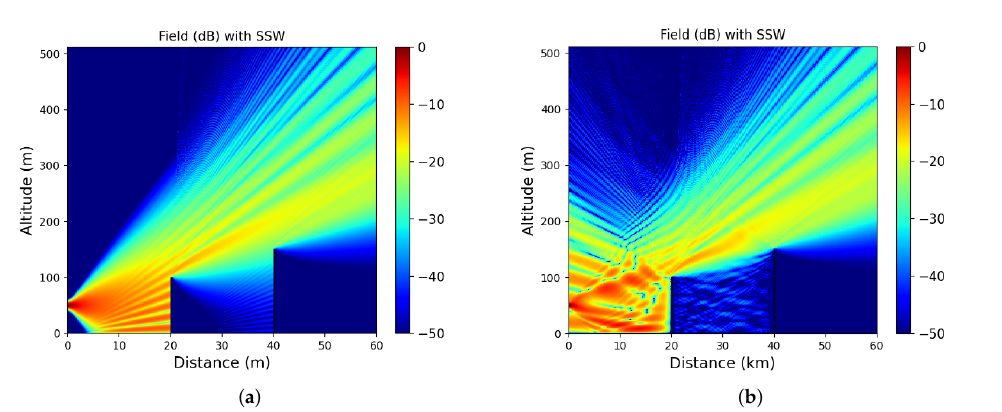
Figure 5. Propagation of the normalized field u (in dB) computed with the one-way and two-way SSW, respectively. ( a ) One-way SSW. ( b ) Two-way